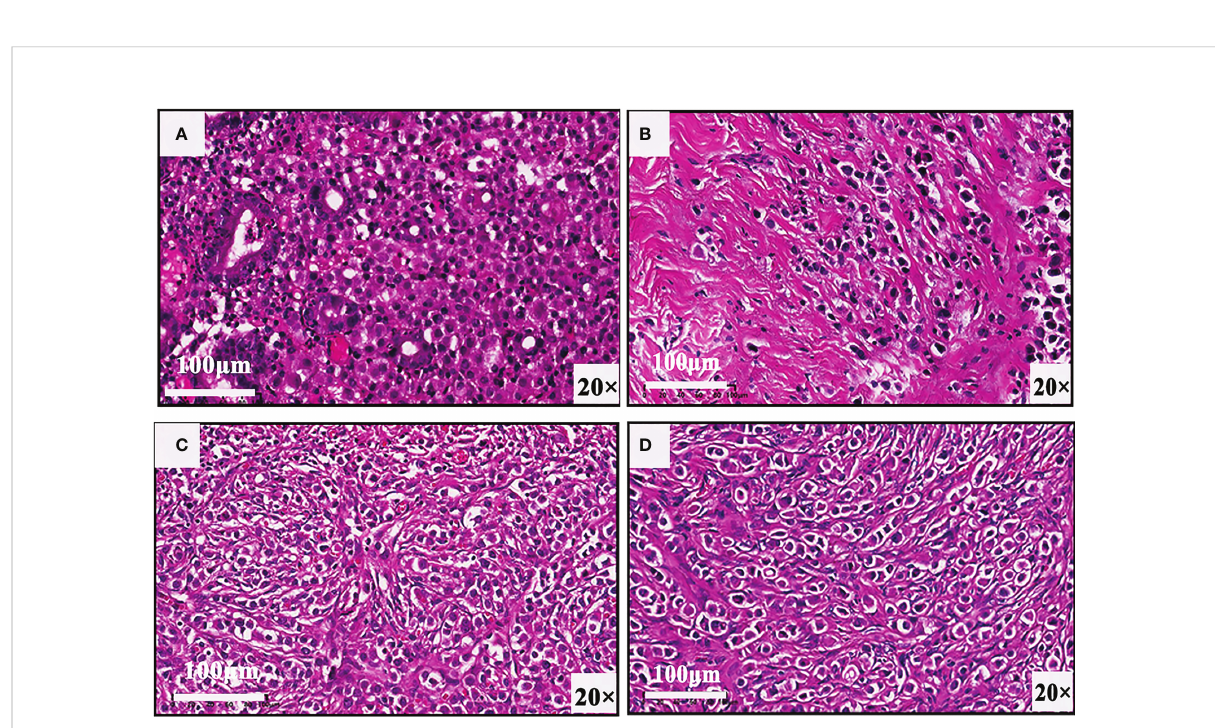
FIGURE 3 Biopsy results of (A) gastric wall, (B) pelvic nodule, (C) right ovary, and (D) left ovary con fi rm that there are gastric, peritoneal, and ovarian metastases from breast cancer.